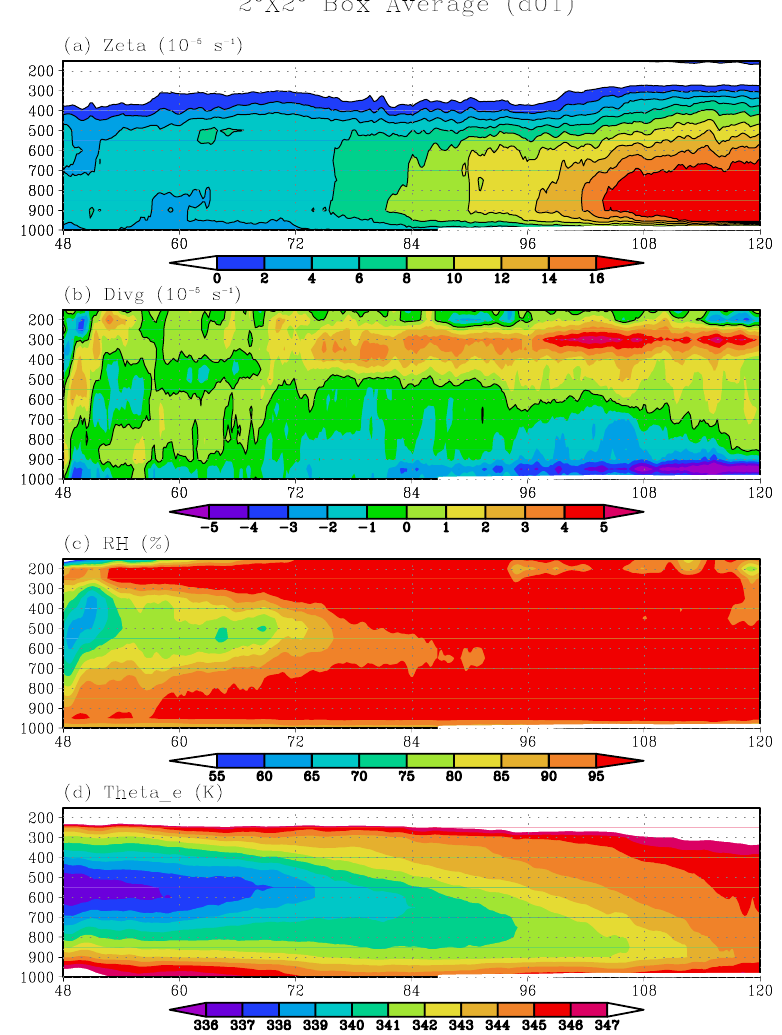
(units: K) following the moving e